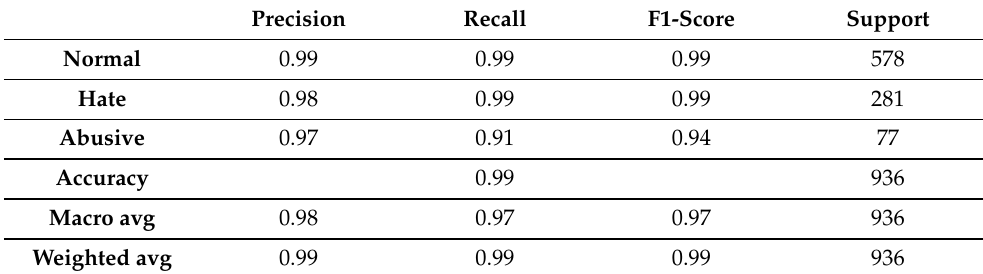
Table 7. Classification report of the ABMM model.